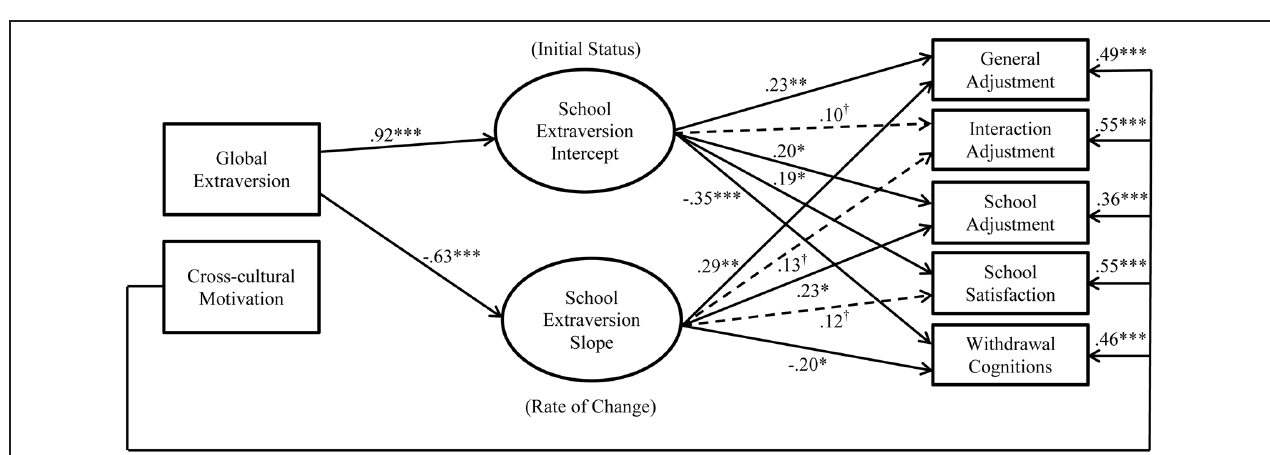
FIGURE 6 | Results from the final Model 2 omitting the paths from cross-cultural motivation to change in school extraversion. ∗ p < 0.05; ∗∗ p < 0.01; ∗∗∗ p < 0.001; † p ≥ 0.05. N = 215. Estimates are standardized estimates from Model 2 (i.e., the unconstrained model). Observed measures of school extraversion were included in the model but not presented here. Solid lines represent significant paths, whereas dotted lines represent insignificant paths.